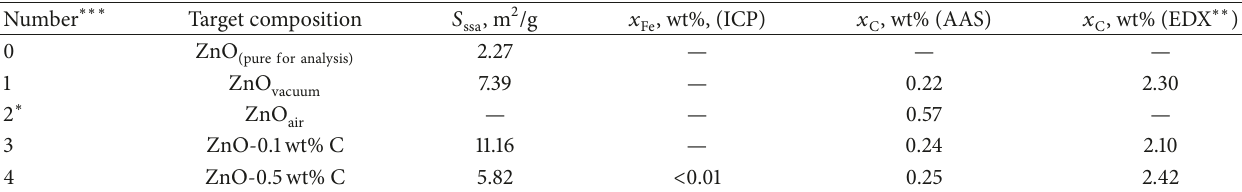
Table 1: The specific surface area ( 𝑆 doped ZnO.